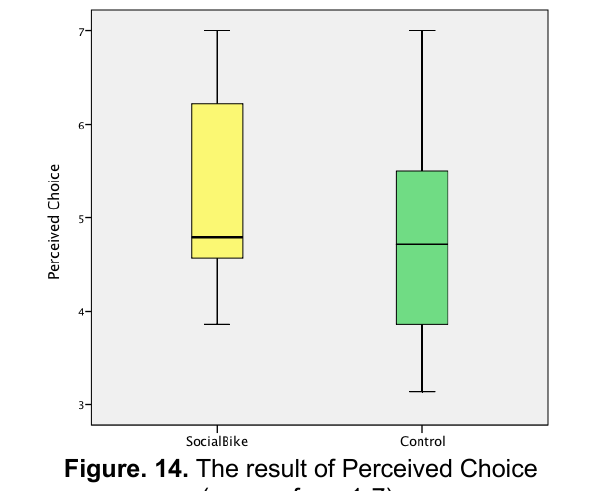
Figure. 14. The result of Perceived Choice (ranges from 1-7).